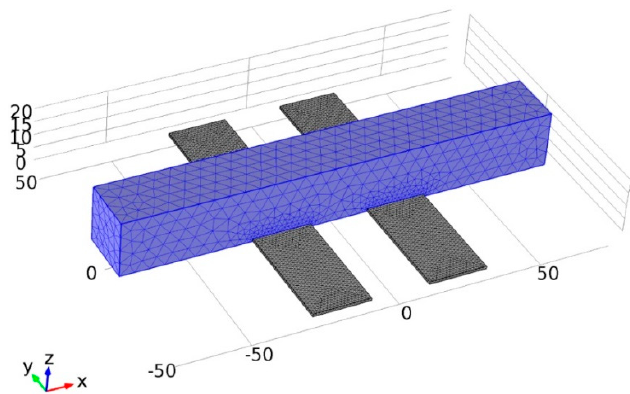
Figure A1. Simulated structure with coplanar electrodes and microchannel (scale in µm).